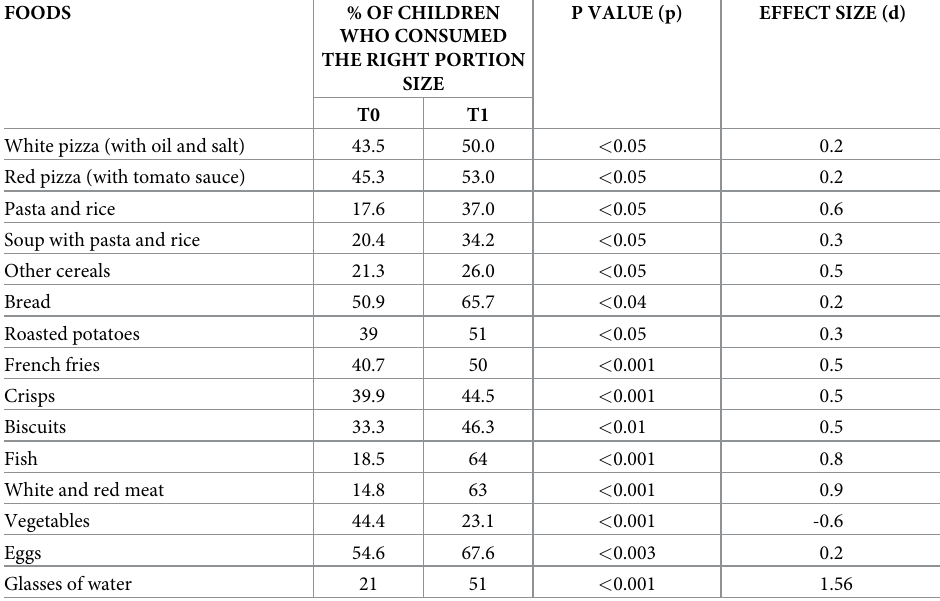
Table 4 shows the statistically significant variations in the number of children who con- sumed the right portion related to the age recommended by NNG before and after using “Nutripiatto”. Regarding protein portion sizes, the percentage of children who consumed the right portion of fish increased from 18.5% to 64% (P < 0.001; d = 0.8), while the percentage of chil- dren who consumed the right portion of white and red meat increased from 14.8% to 63% (P < 0.001; d = 0.9). The percentage of children who consumed the right portion size of French fries and crisps shifted from 40.7% to 50% (P < 0.001; d = 0.5) and from 39.9% to 44.5% (P < 0.001; d = 0.5), respectively.